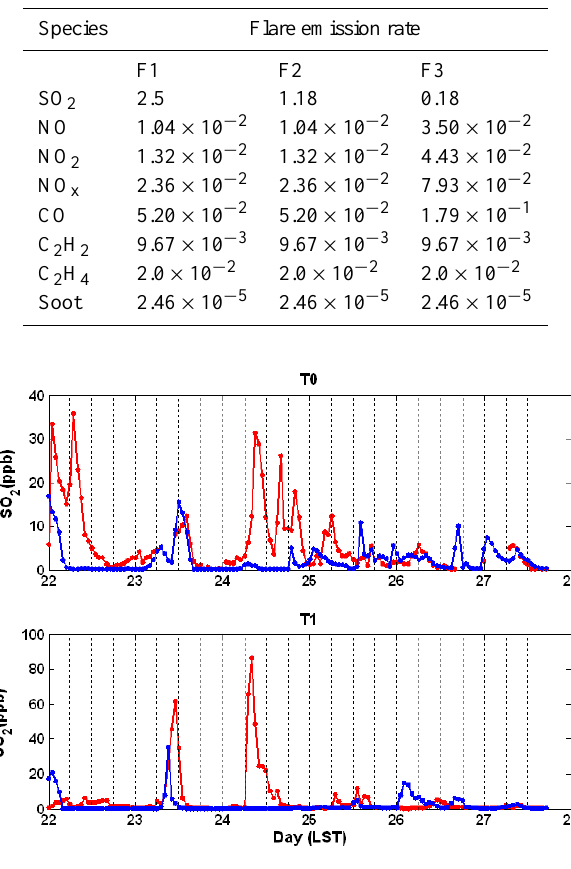
Fig. 3. Comparison of modeled (blue) and observed (red) time series of SO 2 at T0 and T1, for the simulation period. Black dashed lines are plotted every